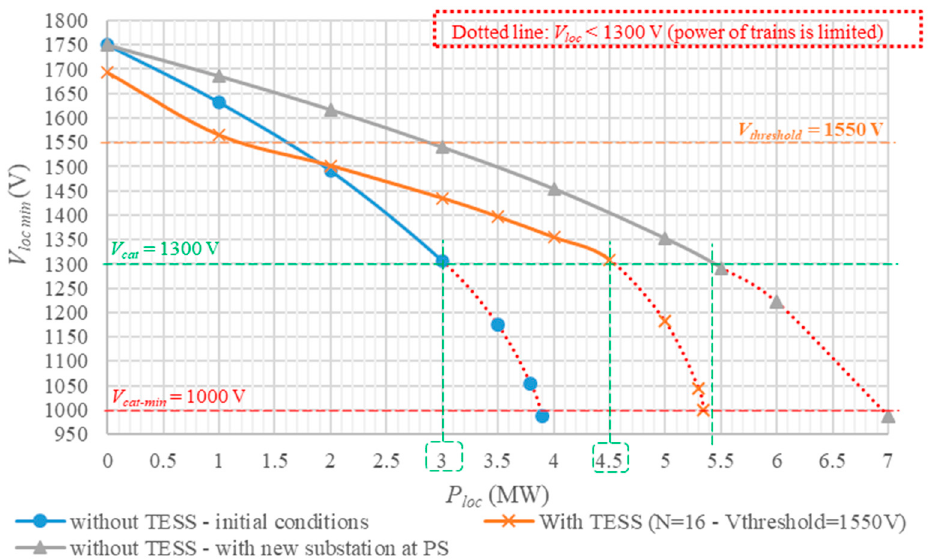
Figure 11. Minimum voltage at the terminals of the locomotives according to their power—with and without TESS ( N = 16 – V threshold = 1550 V)—and with a new substation ( E 0 = 1750 V; R int = 25 m Ω ) at PS, position d/2 .